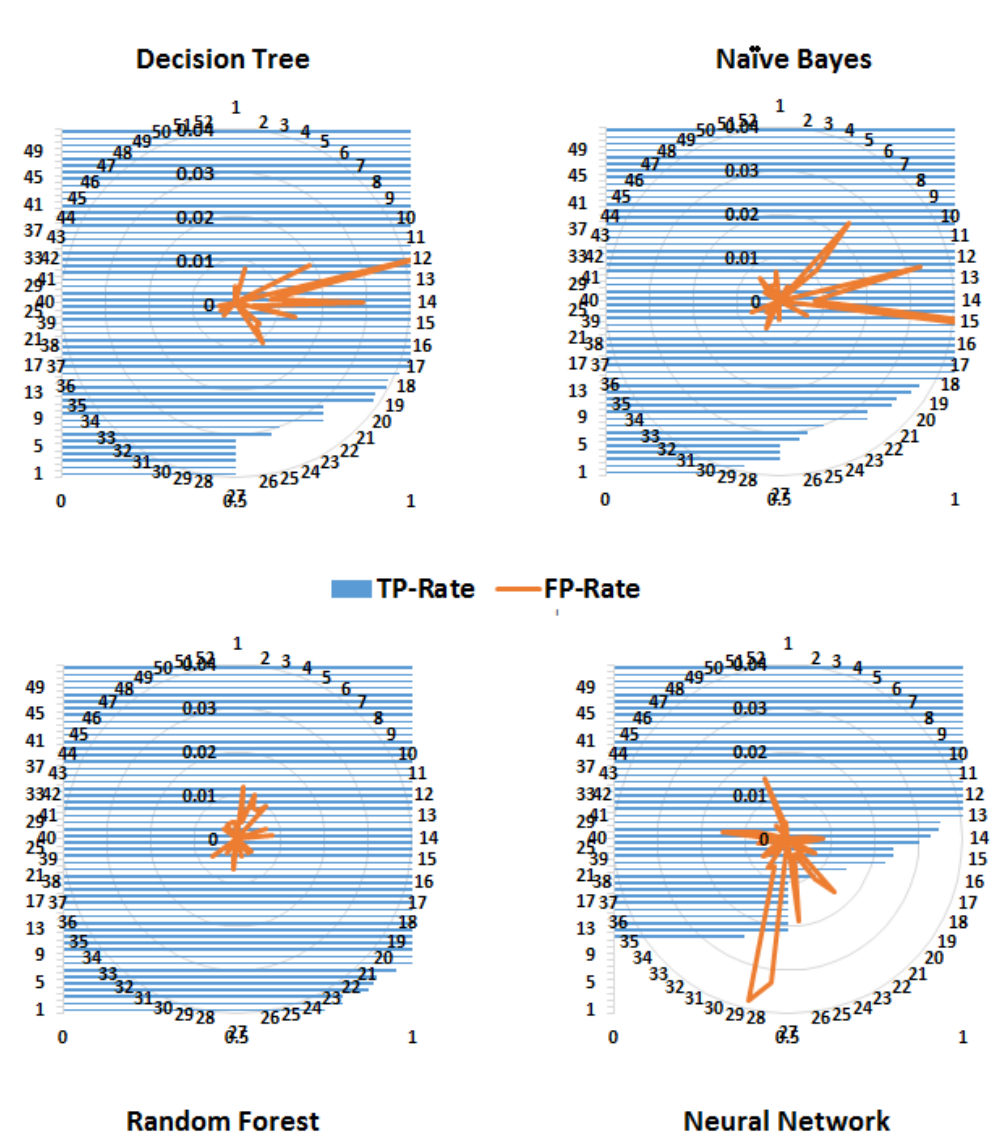
Figure 8. True positive rate (TPR) and false positive rate (FPR) of classification algorithms for 52 classes (diseases) shown in Table 6. TPR is drawn as horizontal bars, whereas FPR is drawn on a circular scale. Although the naïve Bayes algorithm exhibits the smallest FPR, its TPR is also low for a number of classes. However, the decision tree and random forest algorithms exhibit better overall performance, with maximum horizontal bars approaching the maximum value of